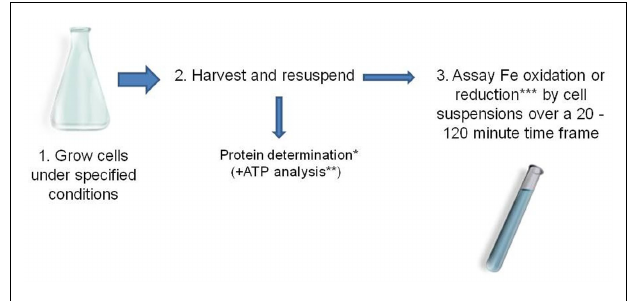
FIGURE 2 |Typical protocol used for determining specific rates of ferrous iron oxidation and ferric iron reduction by acidophilic prokaryotes (*Bradford, 1976; **Okibe and Johnson, 2011; *** e.g., using the ferrozine assay, Lovley and Phillips, 1987).